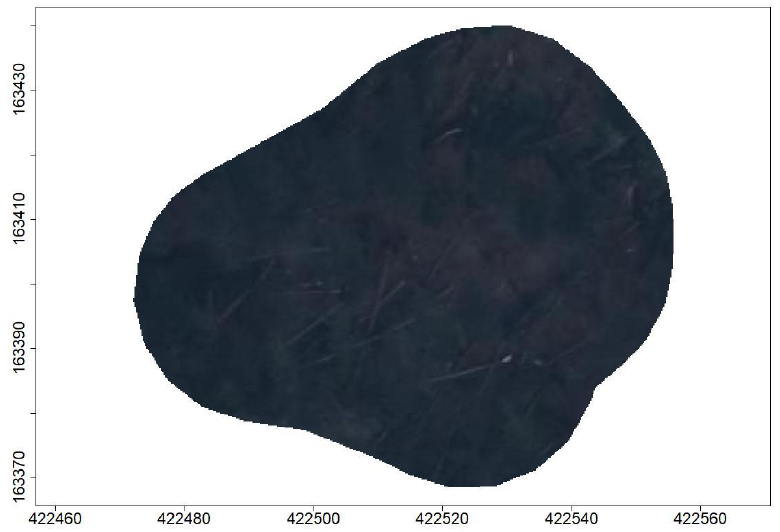
Figure 15. Exemplary sample site Ploecken_10, where the automated detection of fallen stems failed failed for images of this quality level. Coordinates are in meters and in the “MGI/Austria GK M31” for images of this quality level. Coordinates are in meters and in the “MGI / Austria GK M31” coordinate reference system (EPSG-code: coordinate reference system (EPSG-code: 31258).